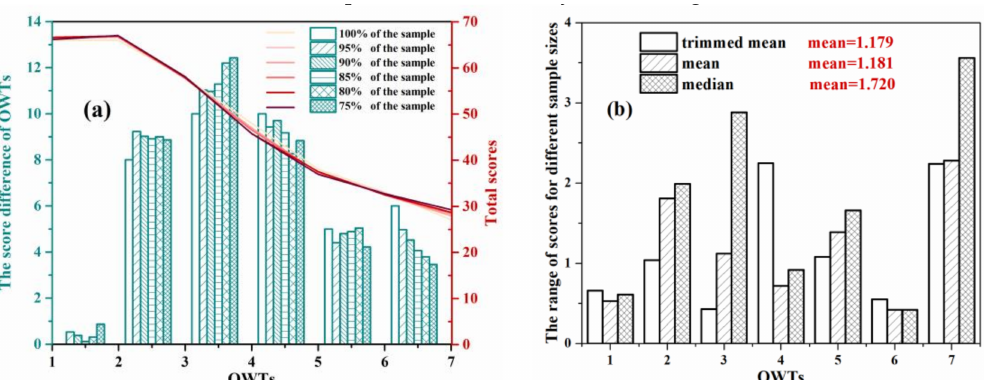
Figure 12. Score differences between adjacent OWTs (bar chart) and the total scores (line chart) obtained by taking the trimmed mean as a statistic under different sample sizes (100%, 95%, 90%, 85%, 80%, and 75%) ( a ). The score ranges of the trimmed mean, mean, and median used as statistics under different sample sizes (100%, 95%, 90%, 85%, 80%, and 75%) ( b ).